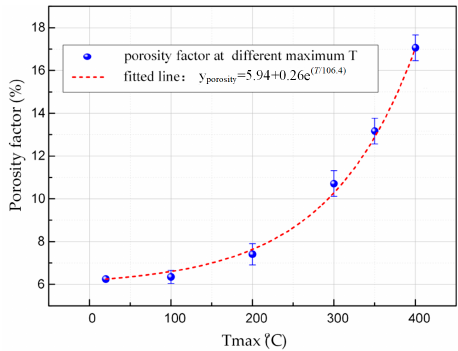
Figure 3. The variation of porosity with thermal shock temperature after a single thermal shock.